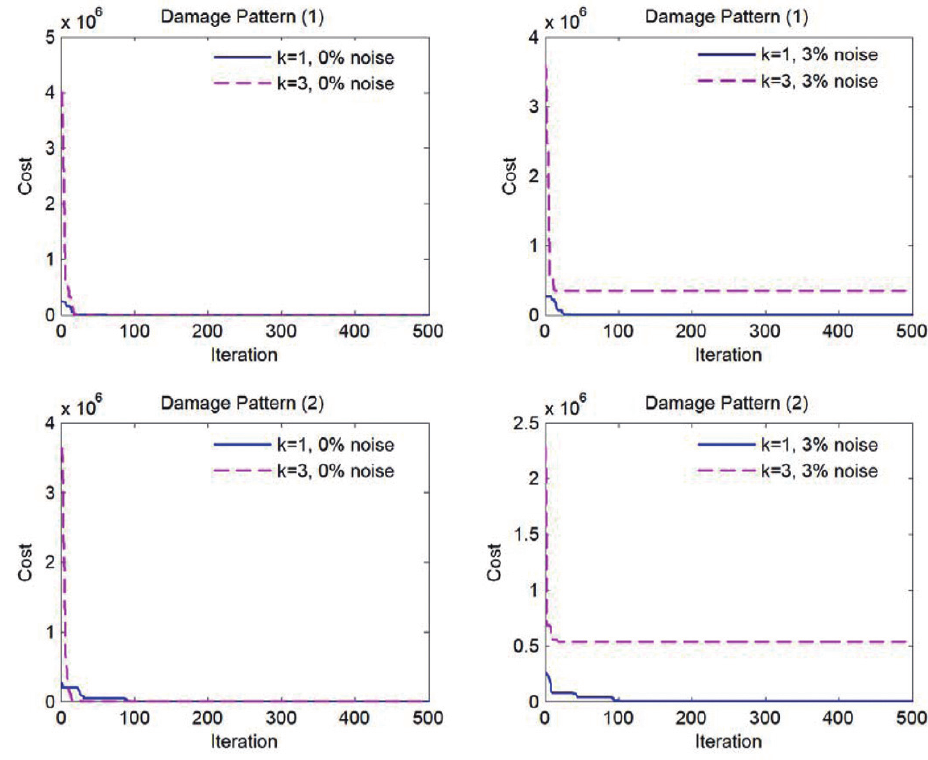
Fig. 6. Convergence curves for two damage patterns of the three-story plane steel